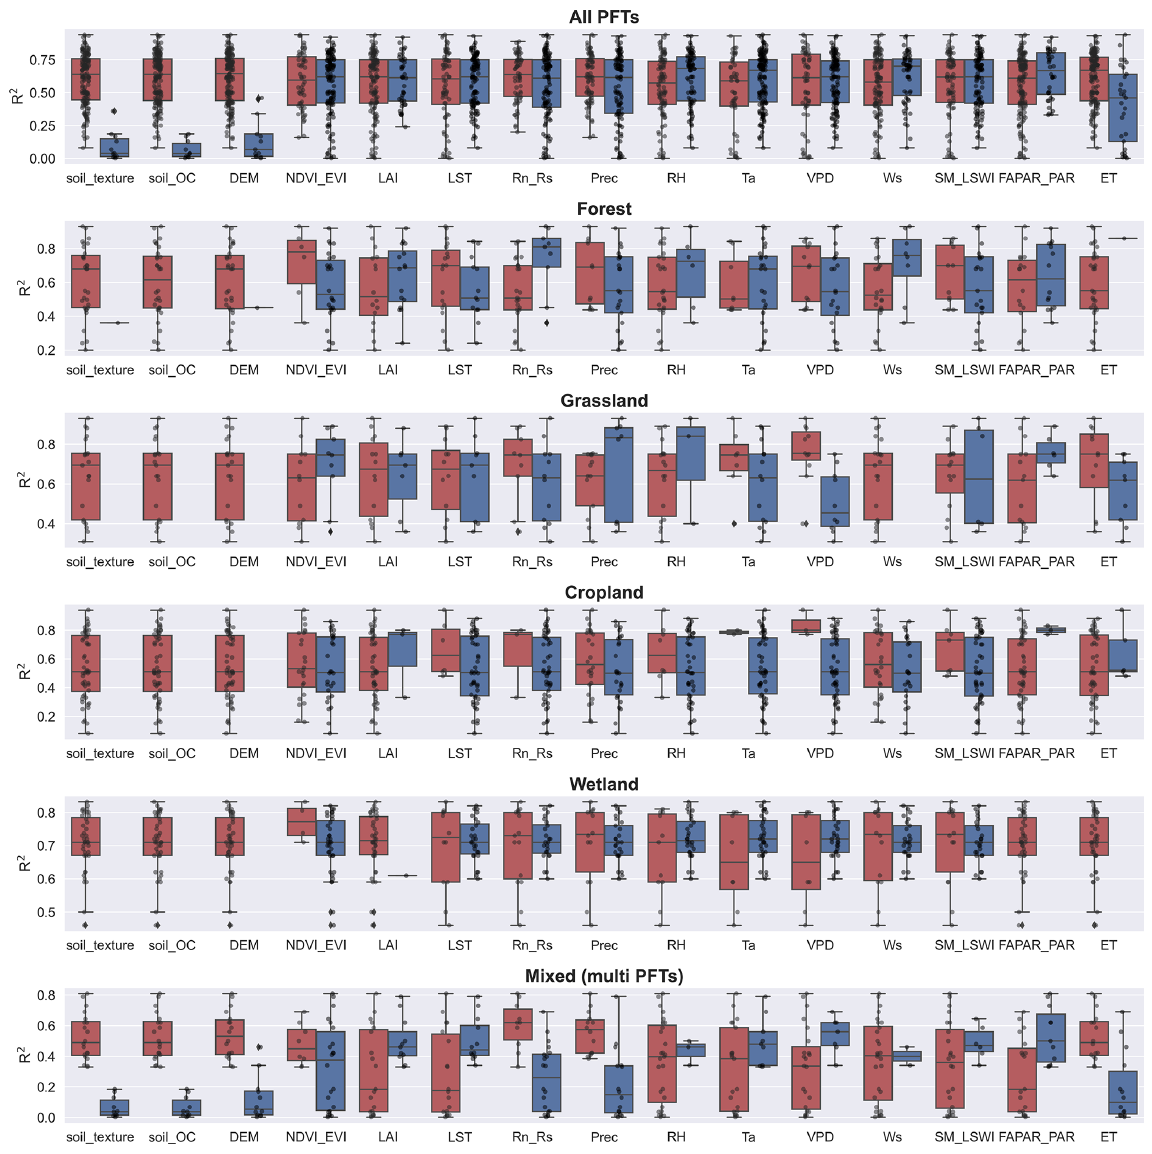
Figure 7. The impact of the various predictors incorporated in models of different PFTs on R 2 . Dark blue boxes indicate that the predictor was used in the model, while dark red boxes indicate that the predictor was not used. Predictors: soil organic content (soil_OC), precipitation ( P ), soil moisture and land surface water index (SM_LSWI), net radiation/solar radiation ( R n _ R s ), enhanced vegetation index (EVI), air tem- perature ( T a ), vapor-pressure deficit (VPD), the fraction of absorbed photosynthetically active radiation/photosynthetically active radiation (FAPAR_PAR), relative humidity (RH), evapotranspiration (ET), leaf area index